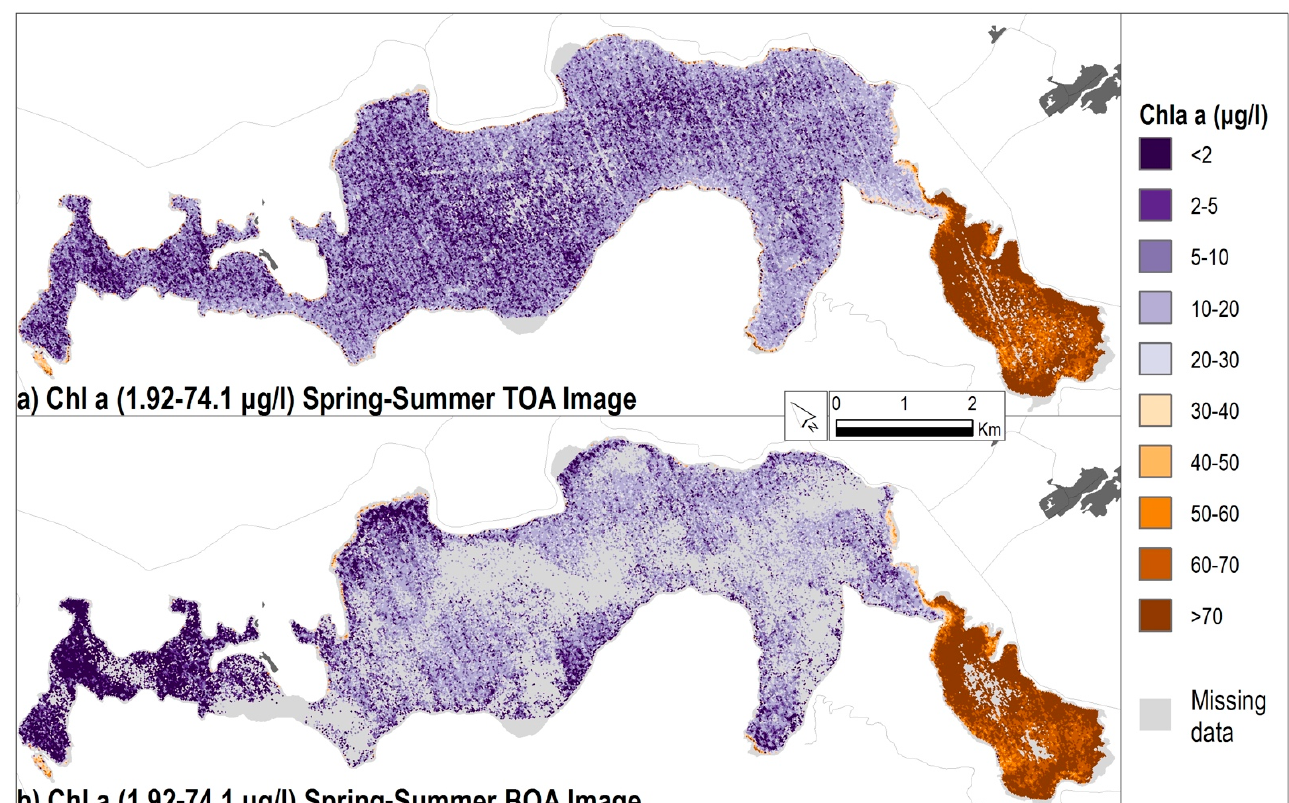
Figure 8. Chl-a concentration maps based on MLR for the spring-summer period, with maximum concentrations, included: ( a ) made with TOA data (L1C) and ( b ) made with BOA data